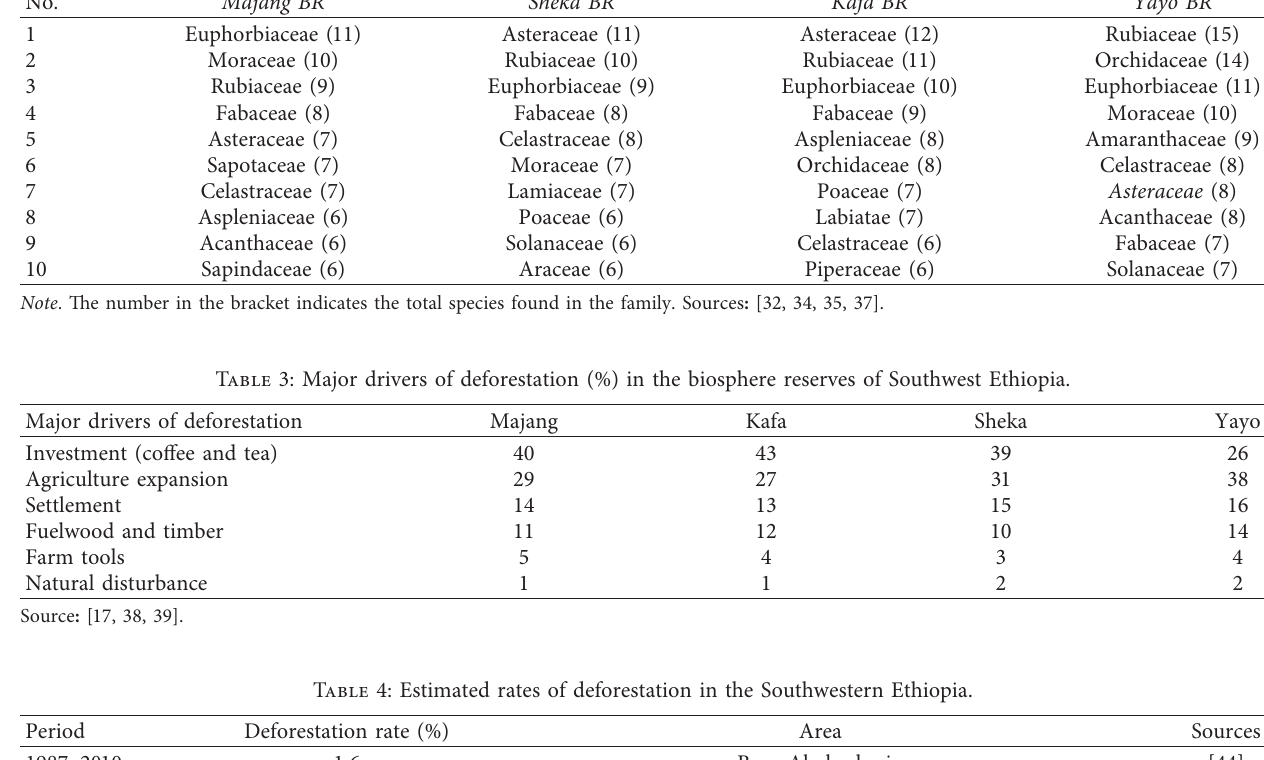
Table 2: Top ten species-rich plant families in the biosphere reserves (BRs) of Southwestern Ethiopia. No.